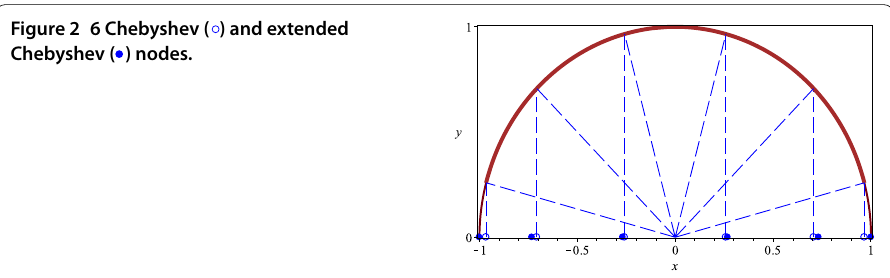
Figure 2 6 Chebyshev ( ) and extended Chebyshev ( )